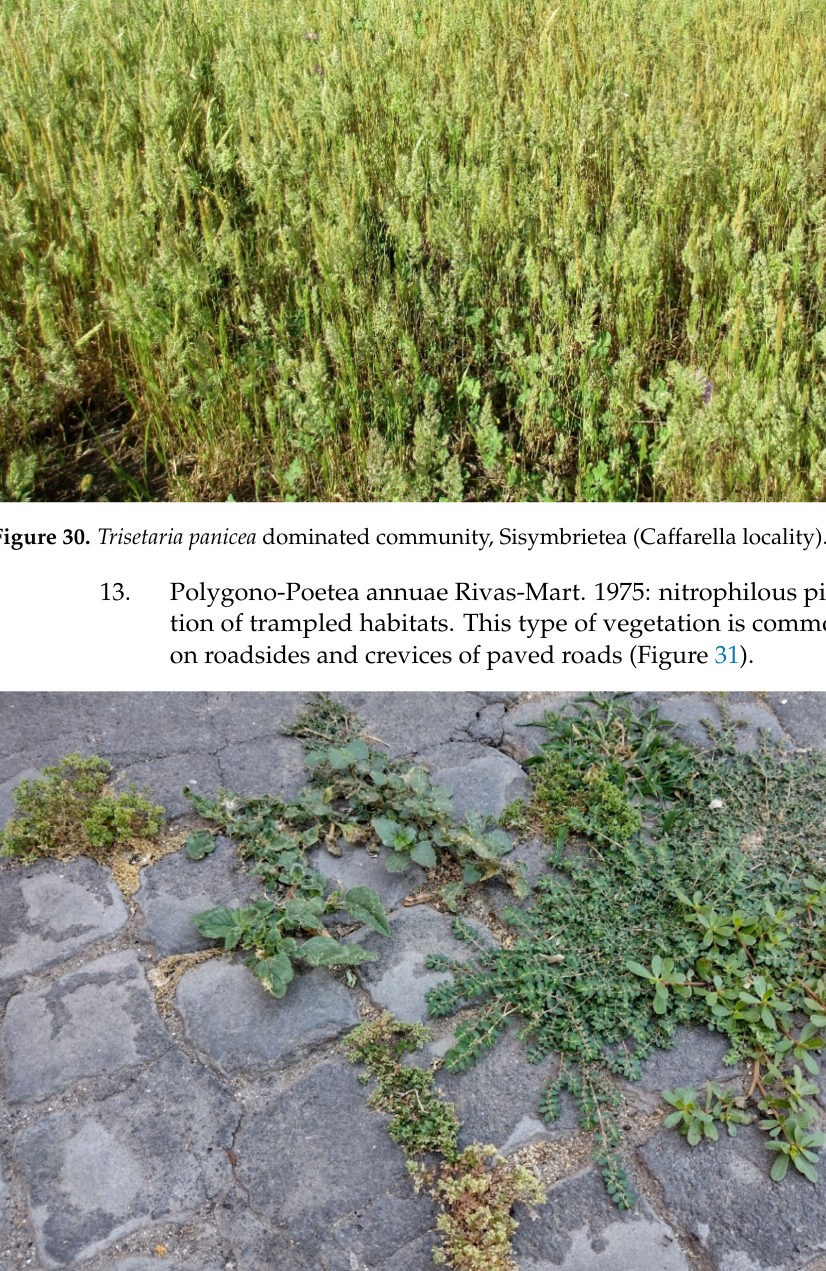
Figure 31. Polygono-Poetea annuae: therophyte communities on crevices of paved Appia Antica street; occurred taxa: Amaranthus retroflexus L., Cynodon dactylon (L.) Pers., Euphorbia prostrata Aiton, Herniaria glabra L. subsp. glabra , Polycarpon tetraphyllum subsp. tetraphyllum , Portulaca oleracea L. subsp. oleracea , Solanum nigrum